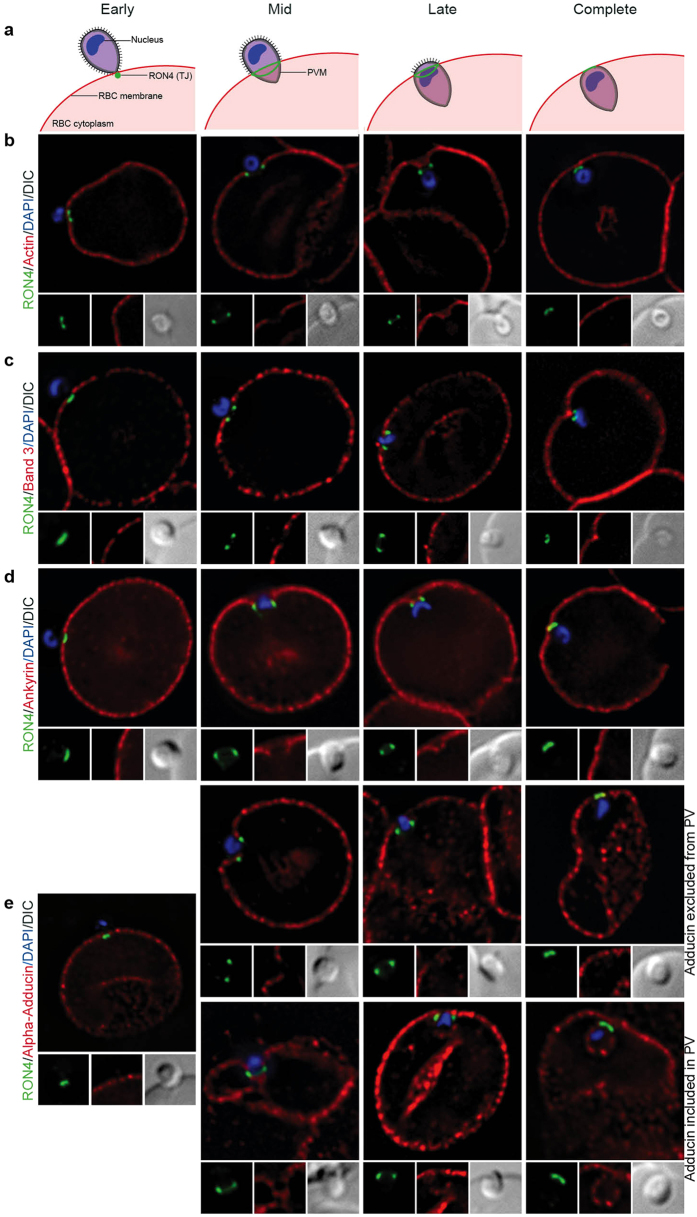
Imaging of the erythrocyte cytoskeleton throughout merozoite invasion.Widefield deconvolution fluorescence imaging of fixed merozoite invasion samples labelled with anti-RON4, DAPI and markers of erythrocyte cytoskeletal proteins. (a) Schematic showing how RON4 labelling allows discernment of early, mid, late and complete invasion events. Early in invasion, during apical attachment, RON4 appears as a single point of fluorescence before expanding to form a ring around the invading merozoite as invasion progresses. When imaged in two dimensions, this ring appears as two single points of fluorescence on either side of the merozoite. The right junction marks the boundary between the erythrocyte plasma membrane and the parasitophorous vacuole membrane, and closes at the base of the parasite at the end of invasion. (b) Erythrocyte actin, labelled by phalloidin-Alexa594. (c,d) Band 3, ankyrin and adducin in invasion labelled with specific antibodies. PVM, parasitophorous vacuole membrane; RBC, red blood cell; TJ, tight junction.